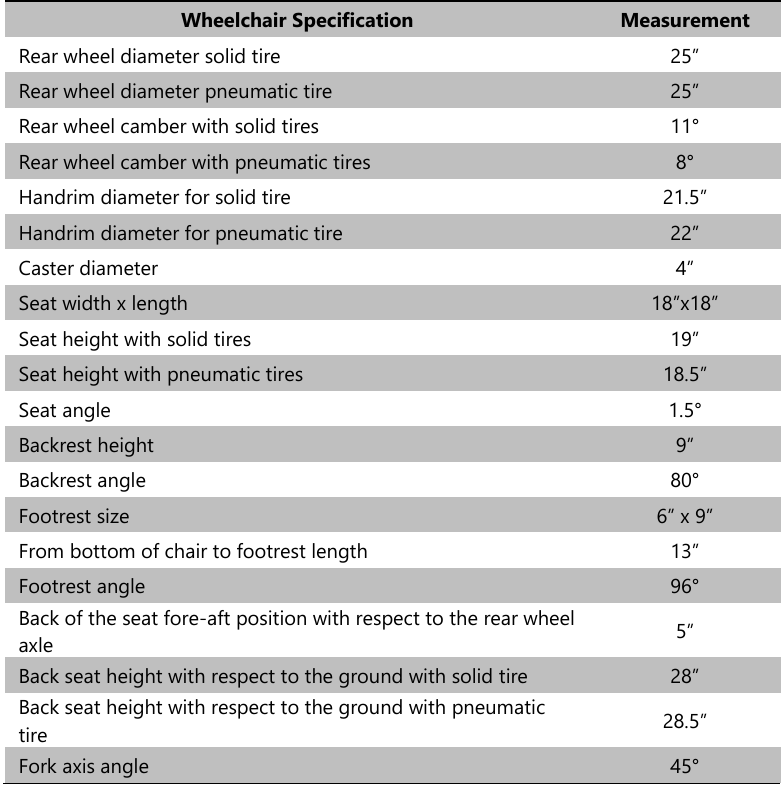
Supplemental Table 1. Wheelchair specifications in accordance with the recommendations of Fritsch et al.